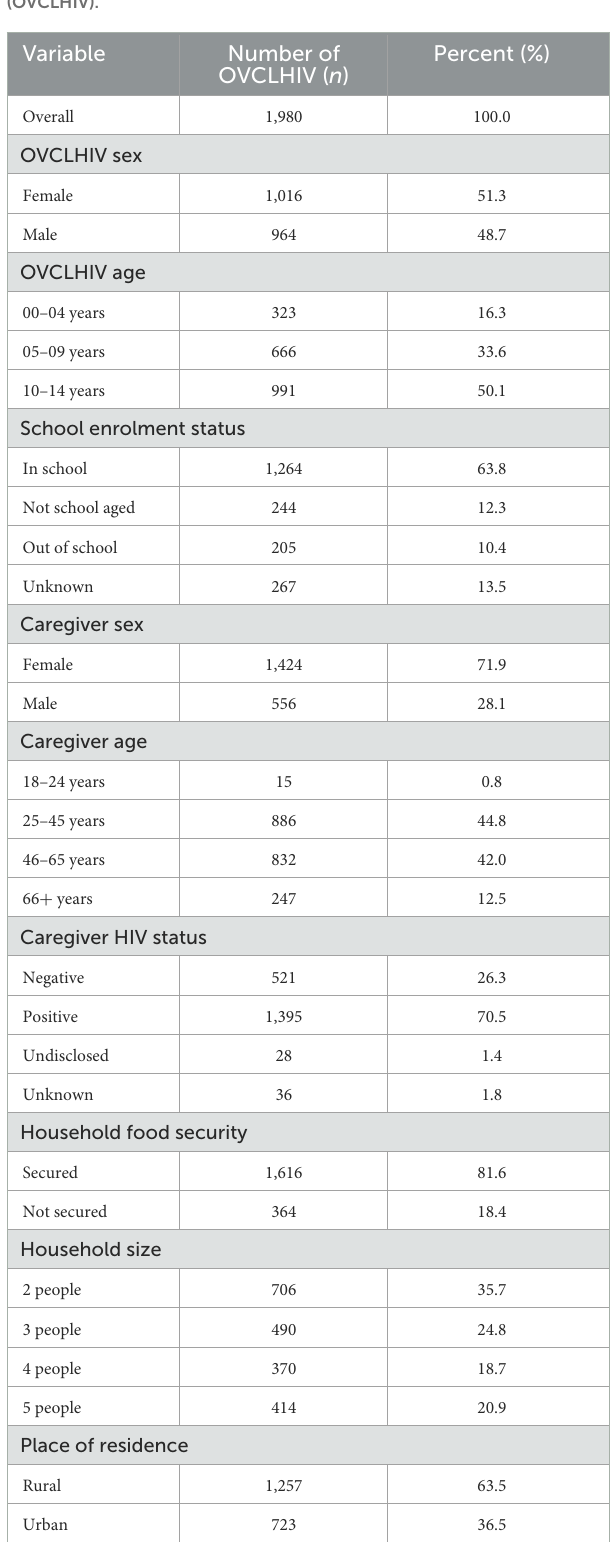
TABLE 1 Profile of orphans and vulnerable children living with HIV